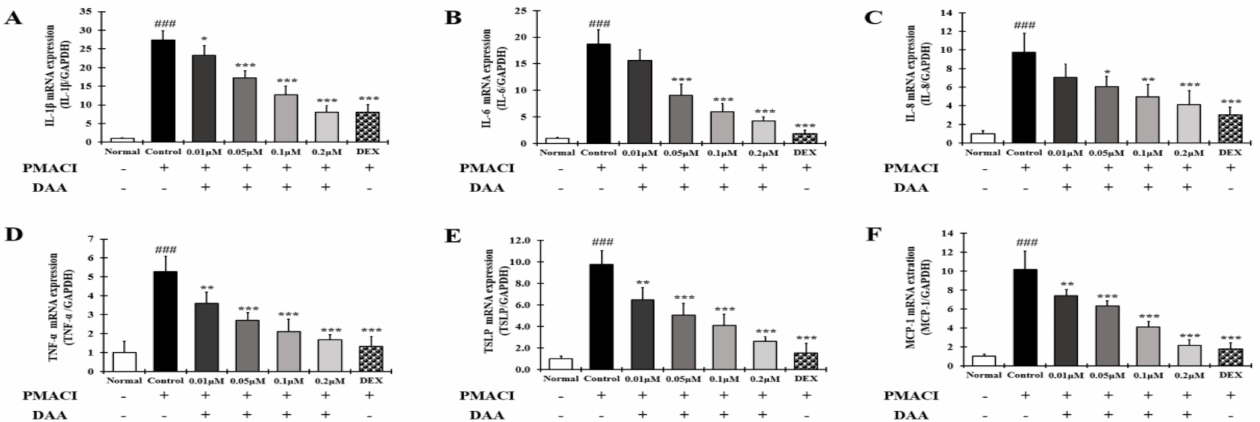
Figure 12. Effect of DAA on the gene expression levels of AD-related cytokines and chemokines in HMC-1 cells. The gene expression levels of IL-1 β ( A ), IL-6 ( B ), IL-8 ( C ), TNF- α ( D ), TSLP ( E ), and MCP-1 ( F ) are shown. Total RNA was isolated from HMC-1 cells and analyzed by RT-qPCR. The expression levels were normalized to that of GAPDH. The results are expressed as the mean ± SD (n = 4). ### p < 0.001 vs. normal; * p < 0.05, ** p < 0.01 and *** p < 0.001 vs. control; DAA was used at 0.01 µ M, 0.05 µ M, 0.1 µ M, and 0.2 µ M. DEX, the positive control, was used at 0.1 µ